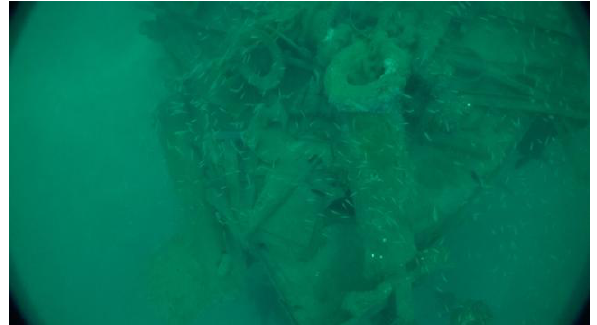
Figure 4: Original video-frame recorded in cruise